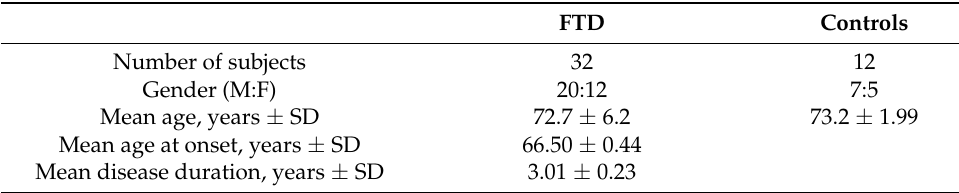
Table 1. Characteristics of patients and